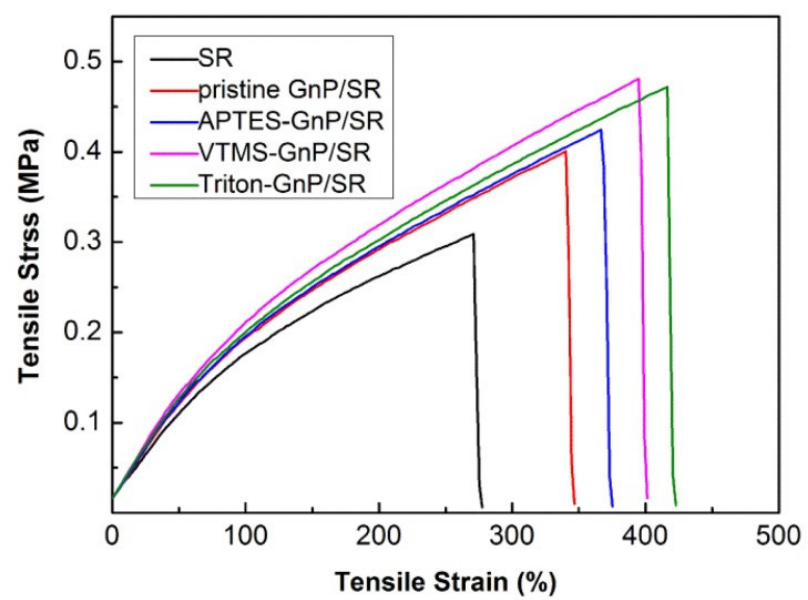
Figure 17. Typical stress-strain curves of neat silicone rubber (SR) and the composites filled with various graphene platelets (GNP). Reproduced with permission from [137], Copyright Wiley, 2016.